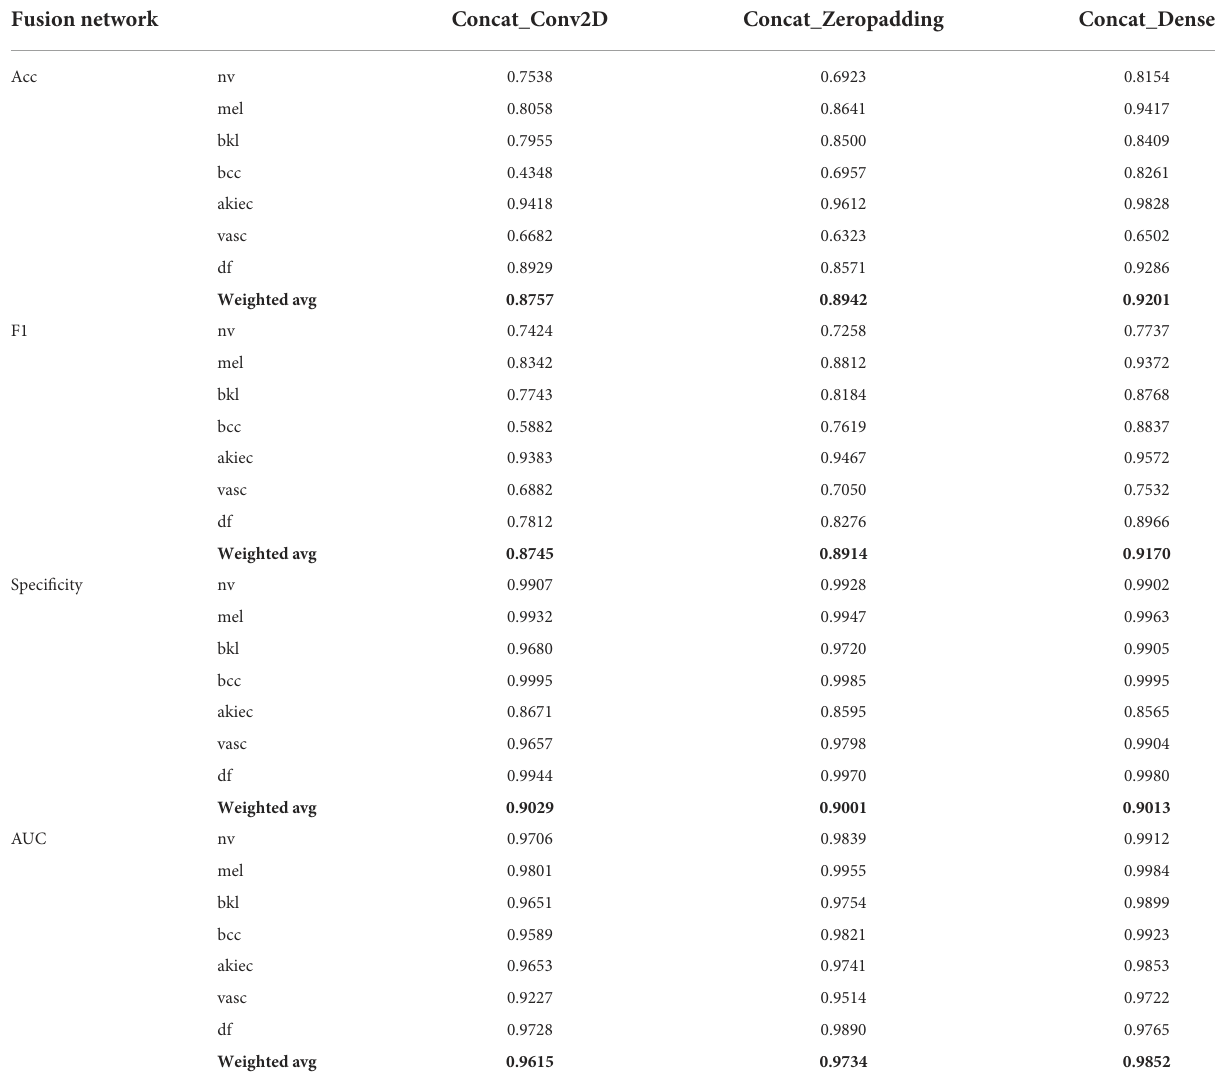
TABLE 5 The influence of different fusion strategies on evaluation